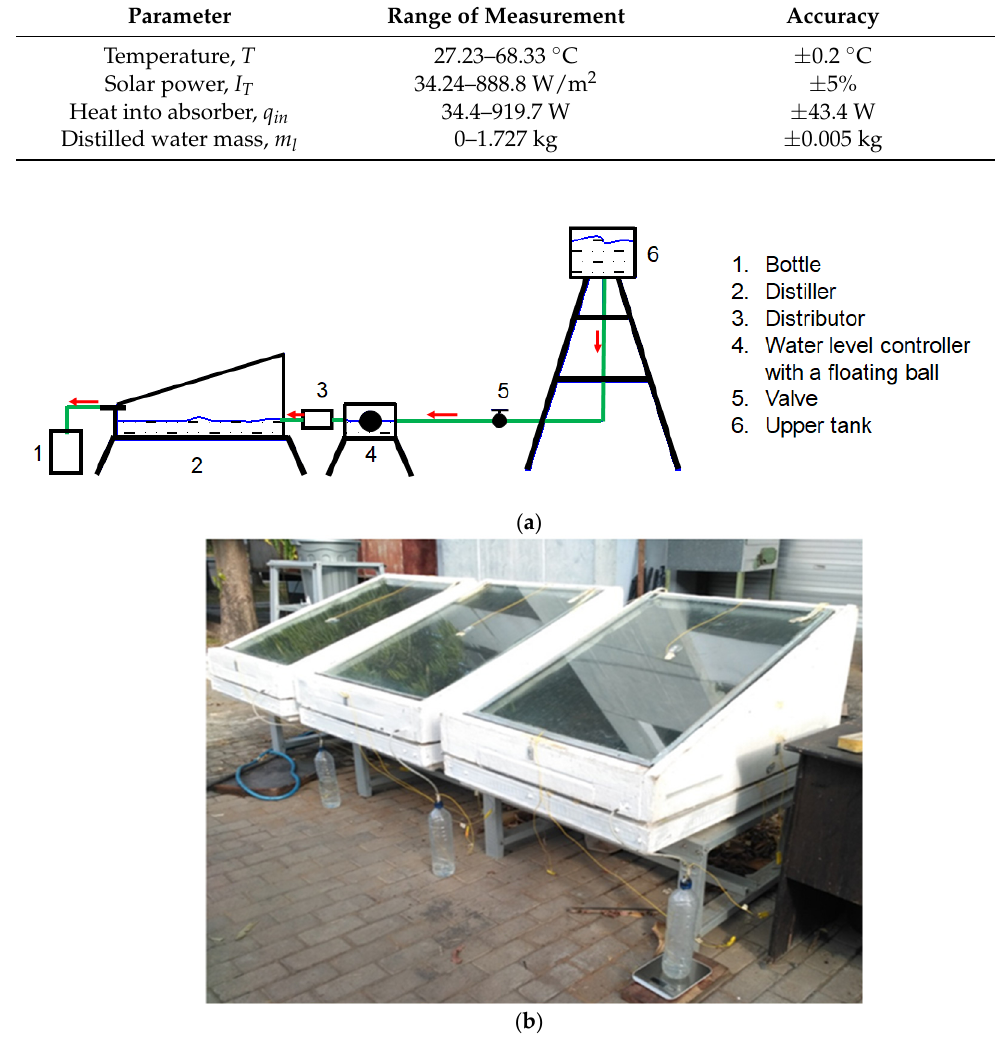
Figure 1. Experimental facility: ( a ) schematic diagram [1] and ( b ) photograph of the distillers.